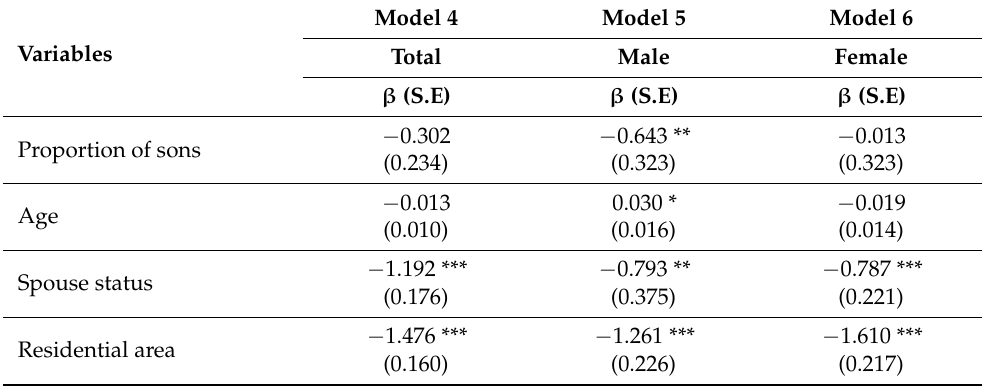
Table 3. Proportion of sons and depression.